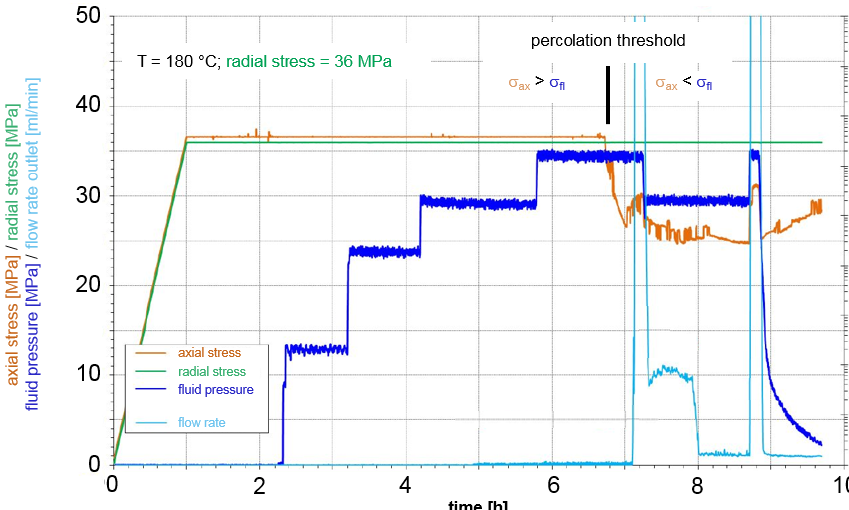
Figure 4. Example of a typical experimental run. After heating to the desired run temperature, axial and radial pressures are increased to isotropic experimental pressure conditions. Then the injection fluid pressure is increased stepwise up to near confinement pressure. The minimum stress criterion ( σ fl > σ min ) is infringed by lowering the axial pressure below the fluid pressure. After passing this percolation threshold, discrete and significant fluid breakthrough is observed. Modified after Minkley et al.